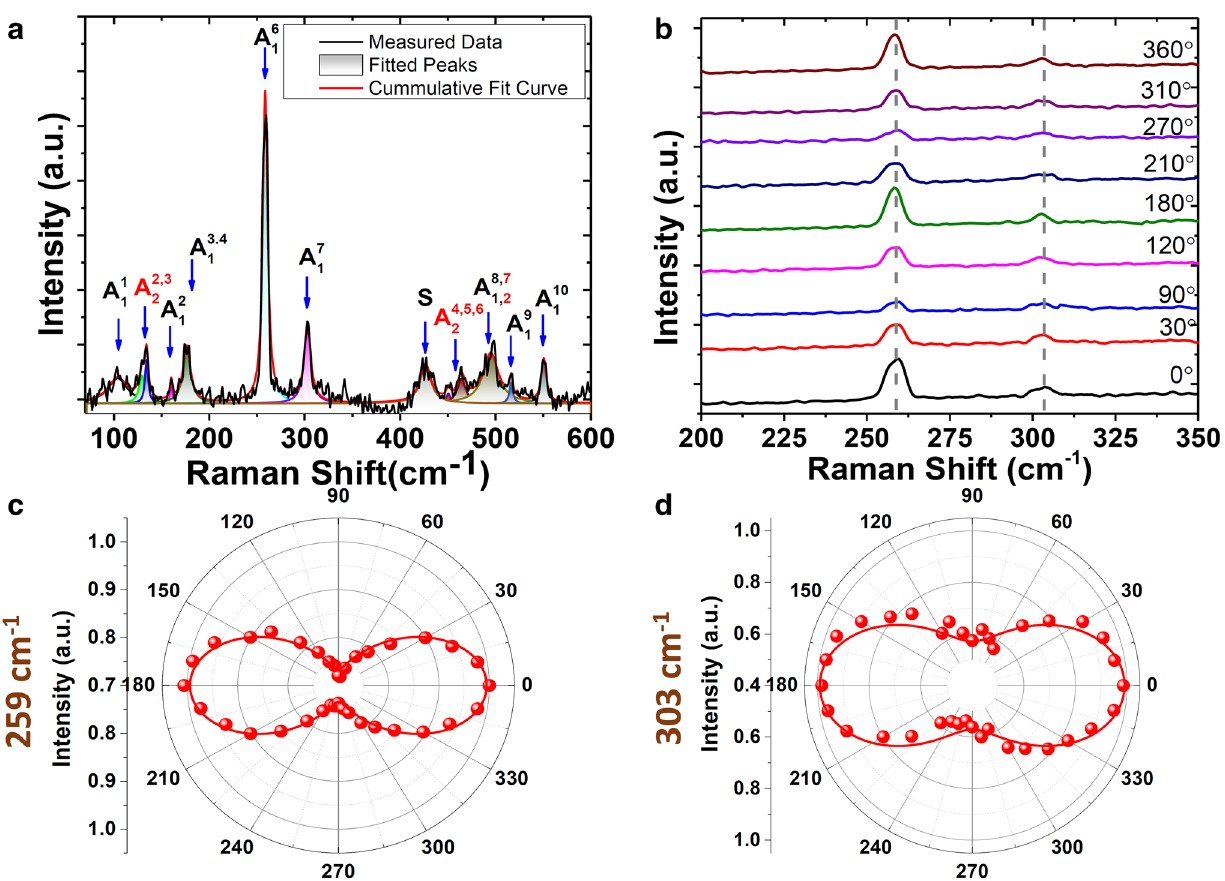
Figure 2. (a) The total Raman spectrum measured from the exfoliated 25 nm-thick SiP flake. (b) The angle- resolved polarized Raman spectra of the SiP flake acquired in the parallel configuration for different pump polarization angles. (c) , (d) the polar plots of the Raman intensities of A spheres are the experimental data and the solid curves correspond to the data fitting by Eq.